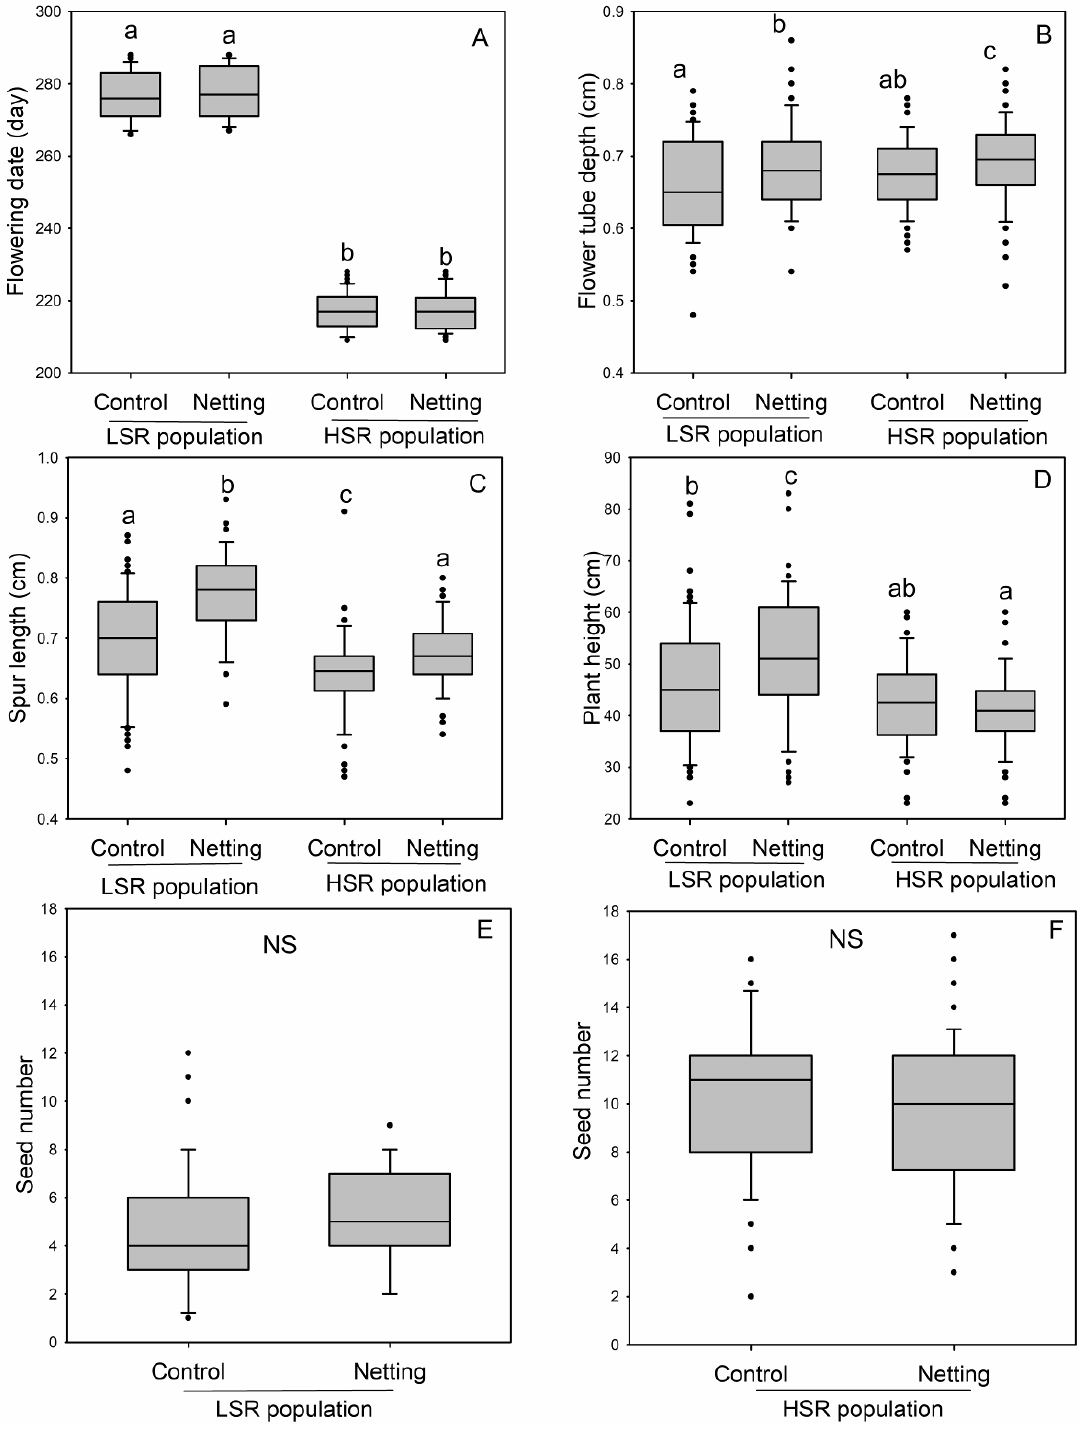
Figure 2. Flowering date ( A ), flower tube depth ( B ), spur length ( C ), and plant height ( D ) between Halenia elliptica netted and control flowers in the low selfing rate (LSR) and high selfing rate (HSR) populations. Seed numbers for the netted and control flowers are also shown for the populations with low ( E ) and high selfing rates ( F ). The results of the comparisons are shown in Table 1. Different letters beside the bars indicate significant differences at the p = 0.05 level.